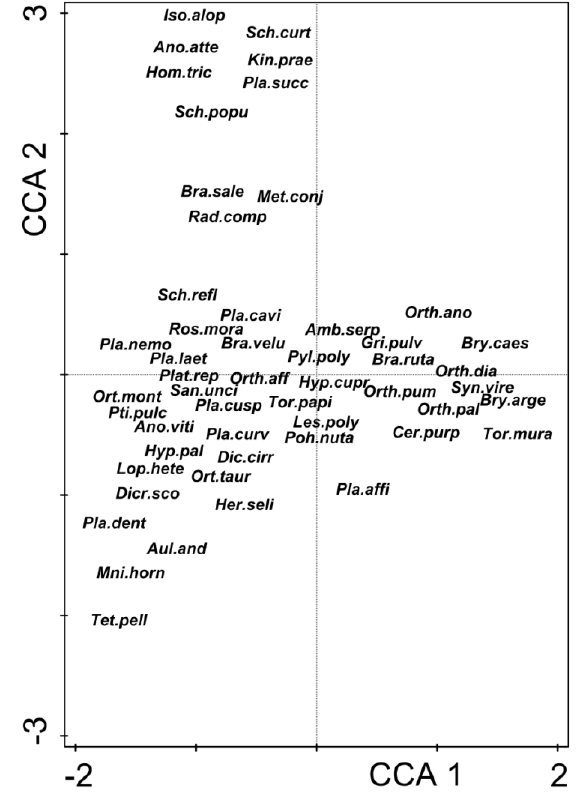
Figure 5. CCA ordination diagram for epiphytic bryophyte species. For a list of species name abbreviations, see Appendix A.